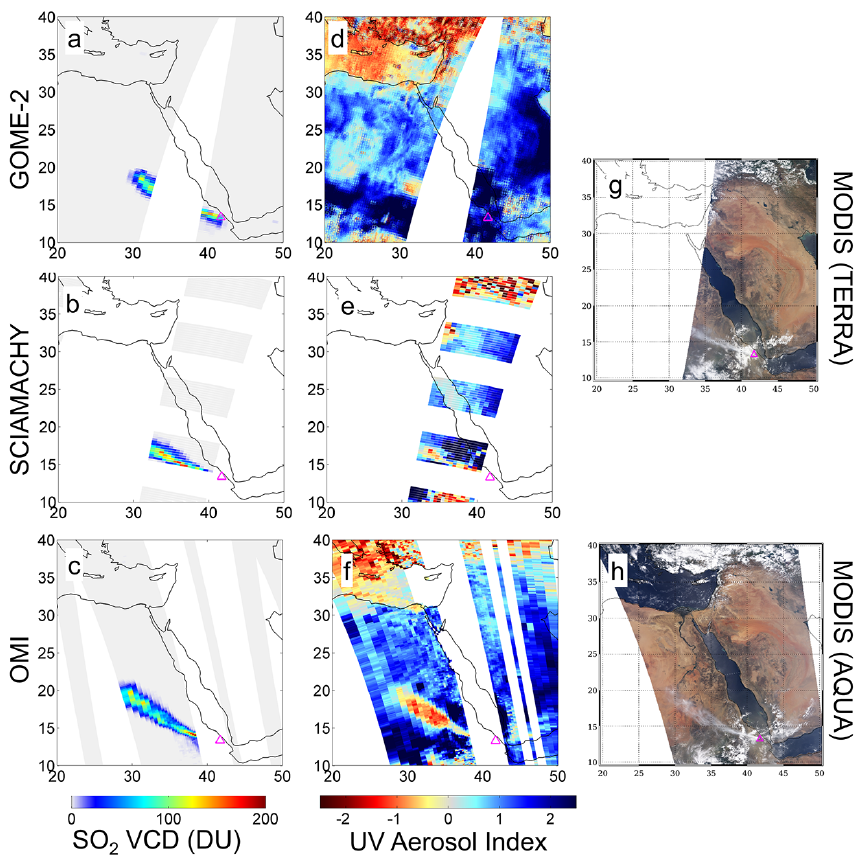
Figure 1. SO 2 vertical column density in Dobson Units (panels a–c ) and UV Aerosol Index (d–f) from GOME-2 ( a and d ), SCIAMACHY ( b and e ) and OMI ( c and f ) and true-colour images from MODIS on TERRA and AQUA ( g and h ) of the region around the Nabro volcano on 13 June 2011. Pink triangles indicate the location of the volcano. The overpass times (UTC) of the different instruments are: 06:25 and 08:05 for GOME-2, 07:40 for MODIS-TERRA, 07:50 for SCIAMACHY, 10:50 for MODIS-AQUA and 11:00 for